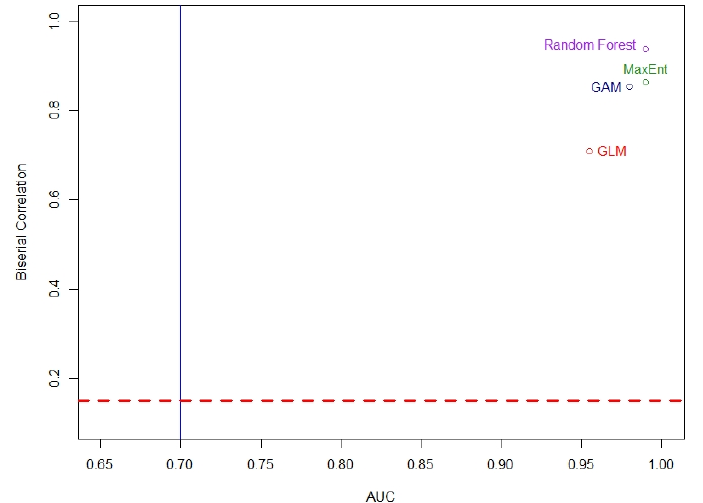
Figure 2. AUC and biserial correlation graph for all models. The red dashed line represents 0.15 value for good biserial correlation. The blue solid line represents 0.7 value for good AUC.